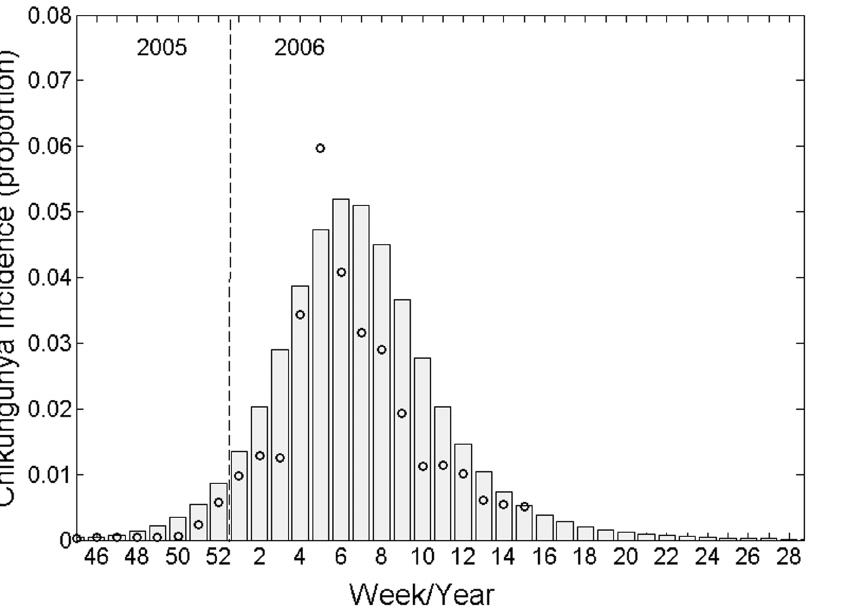
Figure 2. Mathematical model output (bars) fitted to weekly Chikungunya incidence data (circles) collected during the 2005–6 epidemic on Re´union island, Indian Ocean.